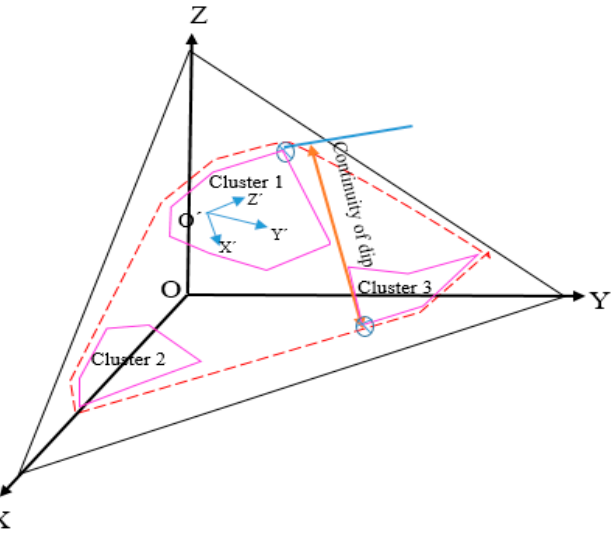
Figure 13. Schematic diagram of continuity extraction.